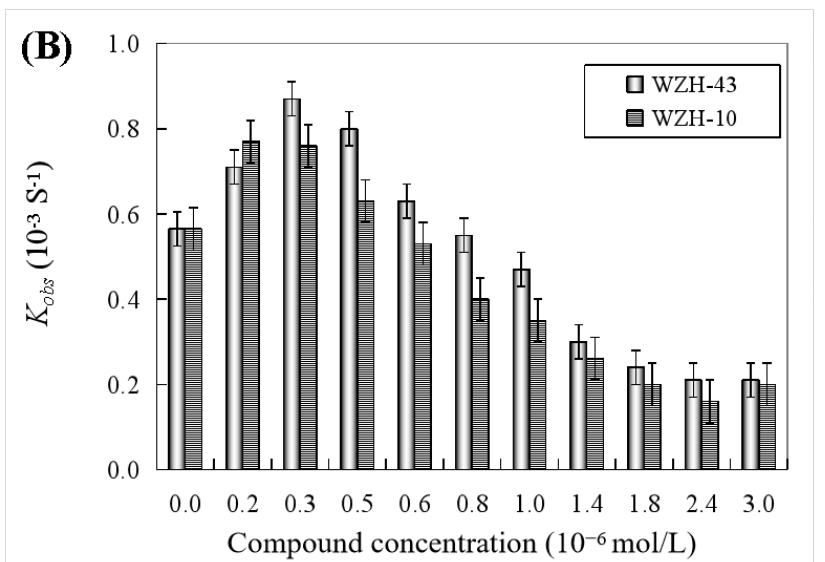
Figure 7. Effect of the two prenylated chalcones on the DNA unwinding activity of BLM helicase by fluorescence polarization ( A ) and change in K obs values of DNA unwinding activity of BLM helicase treated by different concentrations of compounds ( B ).